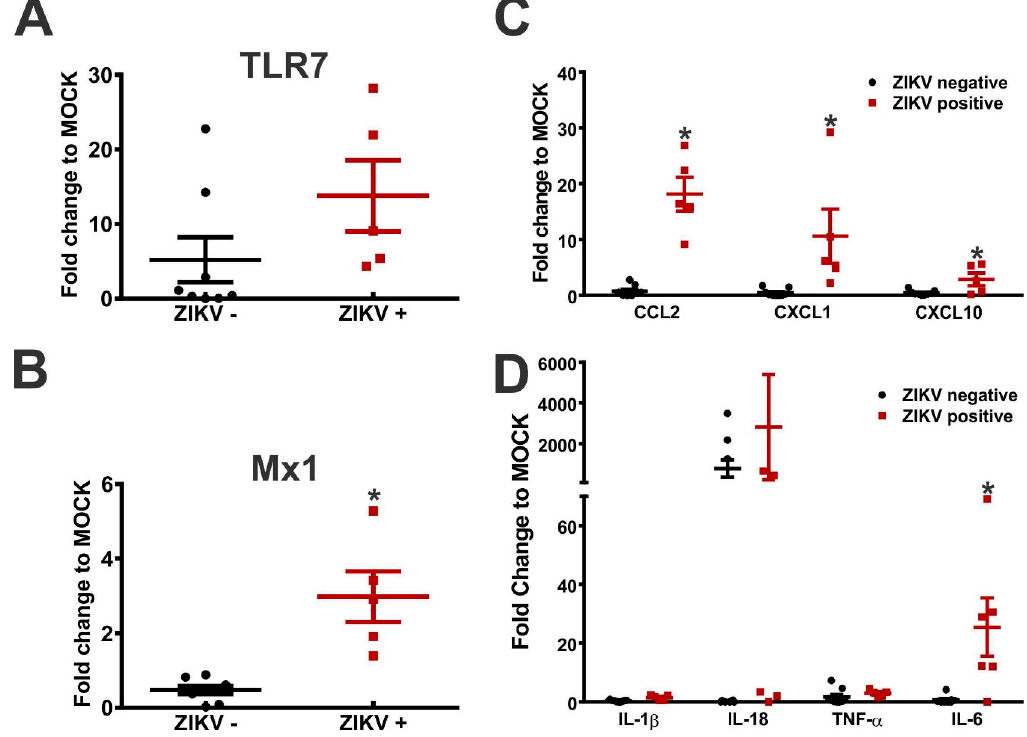
Figure 2. The ZIKV presence in the brain tissue modifies the expression of inflammatory factors in the brains collected from embryos derived from the ZIKV-infected FVB/NJ dams. Fetus brains were collected on GD 17.5 and used to extract total RNA. cDNA was amplified and used for a qPCR analysis. The real-time PCR values were normalized to those of GAPDH of the corresponding samples. The relative levels for each gene were calculated in reference to the mock-infected cells using the ∆∆ Ct method. The graphs show ( A ) TLR7, ( B ) Mx1, ( C ) CCL2, CXCL1 and CXCL10, and ( D ) IL-1 β , IL-18, TNF α and IL-6 gene transcription levels (fold change to MOCK) in brains that were either positive or negative for ZIKV and that were derived from the ZIKV-infected FVB/NJ dams. The data represent the means ± SEM obtained from 6 ZIKV-positive brains and 8 ZIKV-negative brains. * indicates a significant difference, as compared to the ZIKV-negative brains ( p < 0.05).